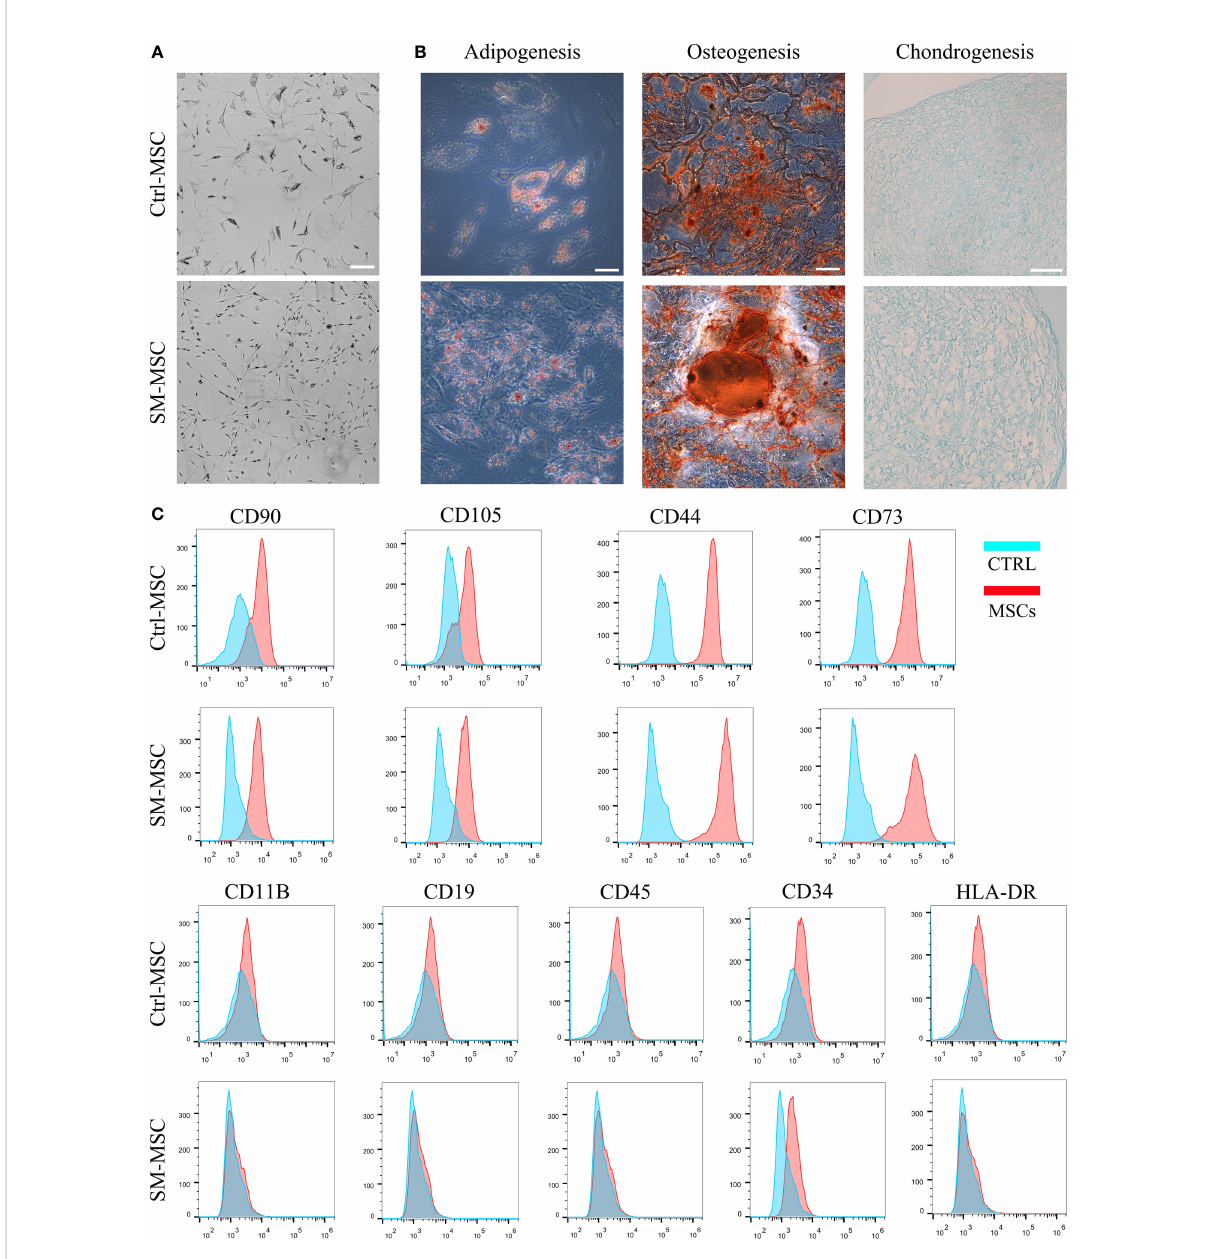
FIGURE 1 Analysis of MSC phenotype and differentiation potential. (A) Morphology of MSCs cultured with or without SM-ACY. (B) Adipogenic, osteogenic, and chondrogenic differentiation properties of MSCs. (C) Analysis of MSC surface marker expression. Scale bar = 100 m